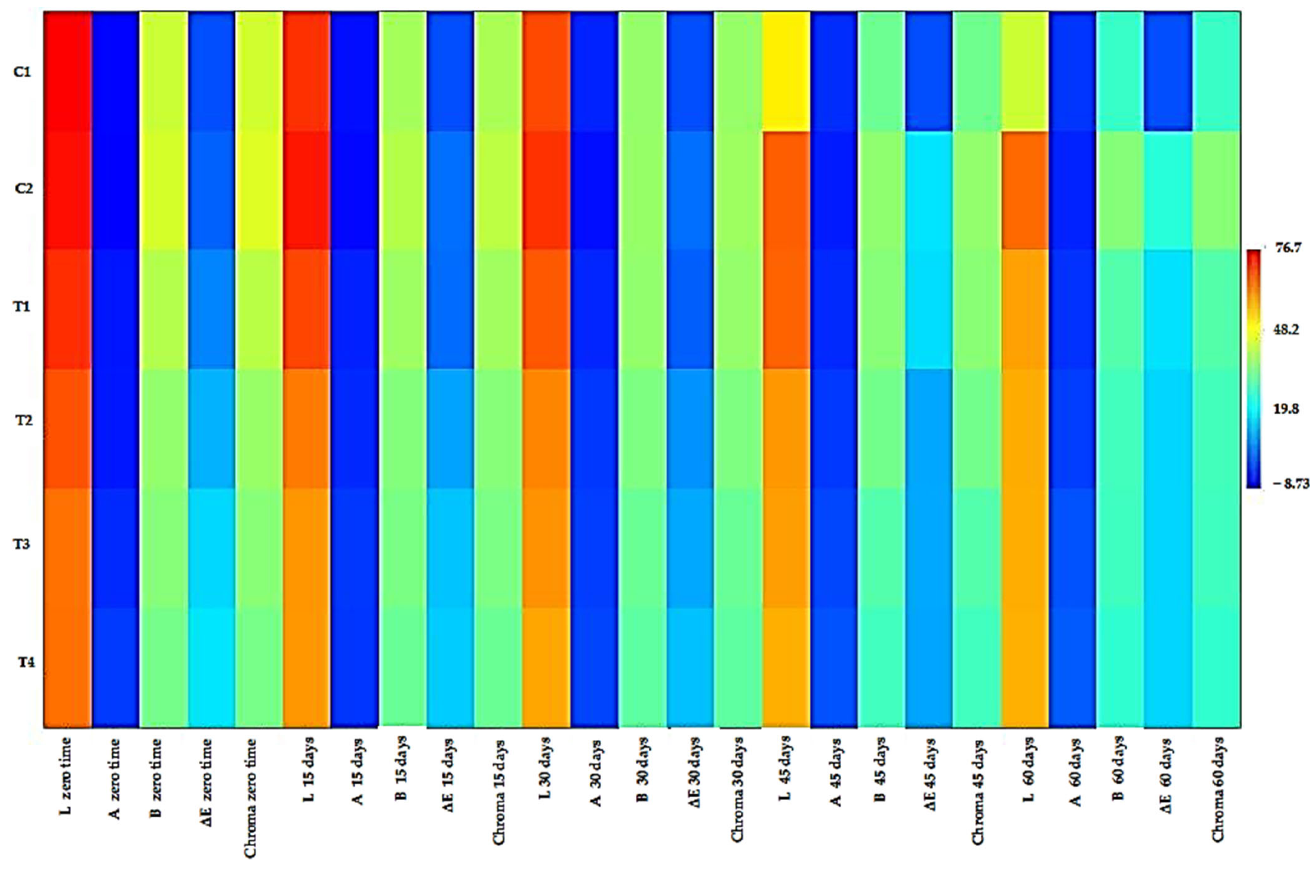
Figure 5. Correlation of the color characteristics of mayonnaise samples enriched with RCFE during storage.